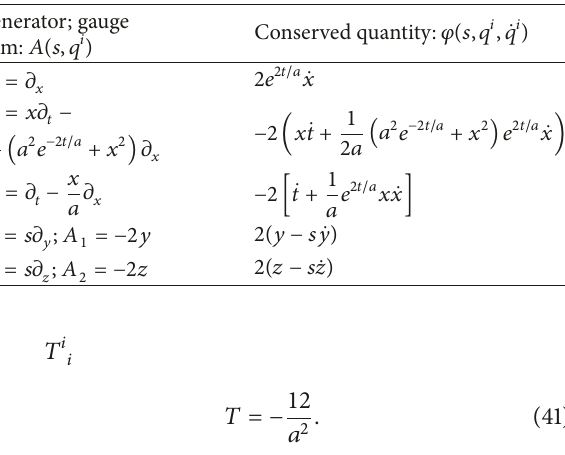
Table 7: Conserved quantities corresponding to each Noether